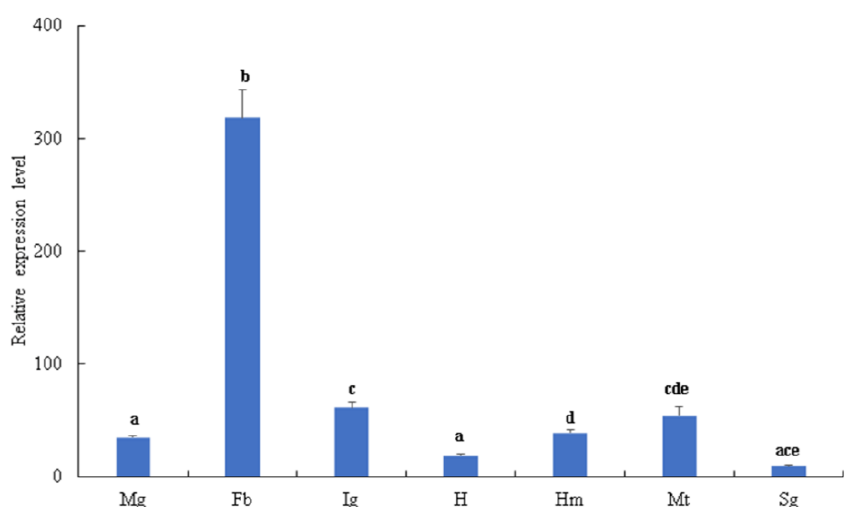
Figure 1. Tissue distribution of Bmserpin2 in the 5th instar B. mori larvae. The mRNA levels of Bmserpin2 were analysed by qRT-PCR. The Bmserpin2 transcript level in the midgut was used as the calibrator. Data were normalised with Bombyx mori glyceraldehyde 3-phosphate dehydrogenase (GAPDH). Error bars show mean ± standard deviation (SD, n = 3). Significant difference is indicated with different letters (one-way ANOV followed by Tukey’s test, p < 0.05). Mg: Midgut, Fb: Fat body, Ig: Integument, H: